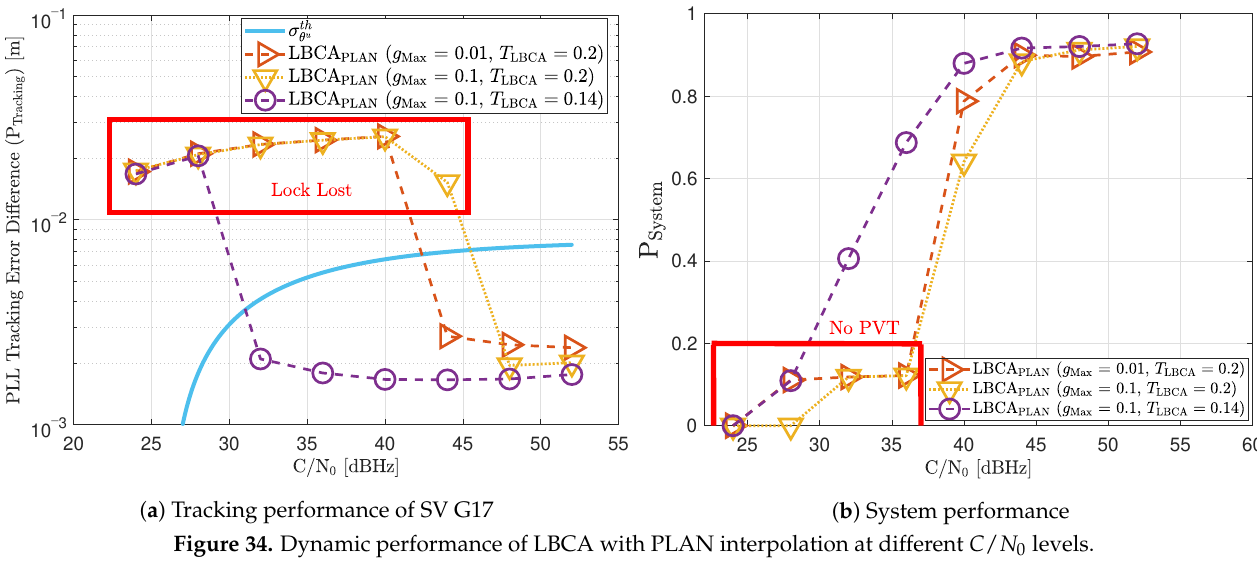
Figure 34. Dynamic performance of LBCA with PLAN interpolation at different C / N 0 levels. The LBCA + PLAN technique with S = 0.1 and T LBCA = 0.14 is the unique adaptive tracking technique that can still track the signal at 32 dBHz in the presence of high LOS jerk dynamics. Once dynamics are present, the estimated loop bandwidth goes from 11 Hz to 17.5 Hz to follow the phase error dynamics (see Figure 35a). After that, the loop bandwidth goes back to 11 Hz and repeats when new dynamics are detected. The LBCA + PLAN technique with S = 0.1 and T LBCA = 0.2 loses lock at